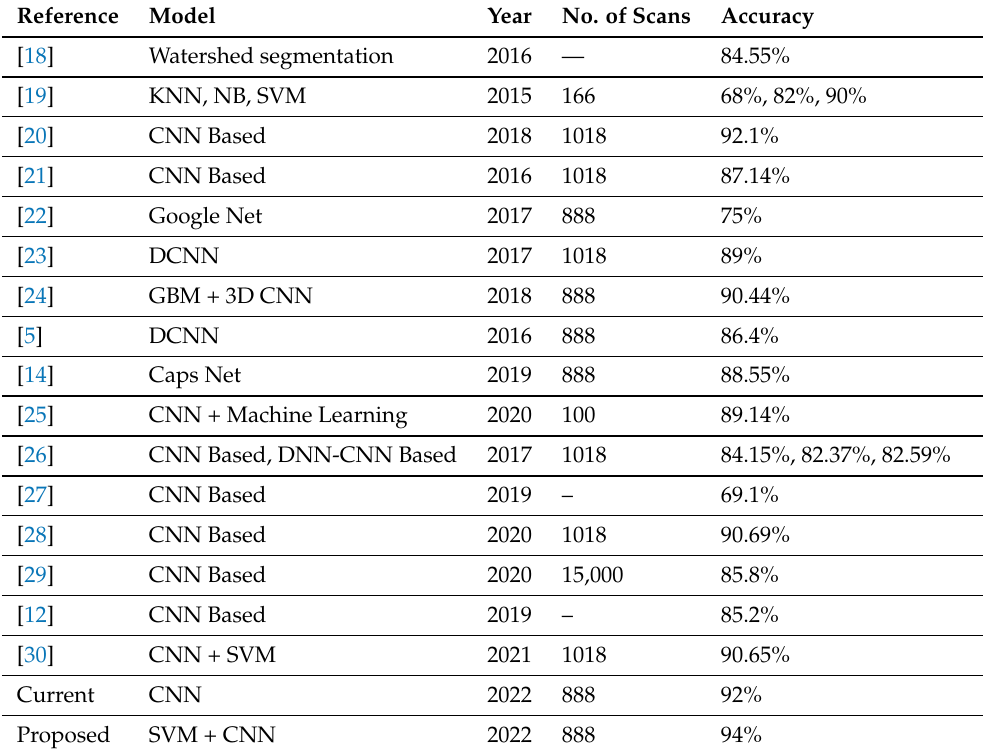
Table 2. Comparison of the proposed model with state-of-the-art